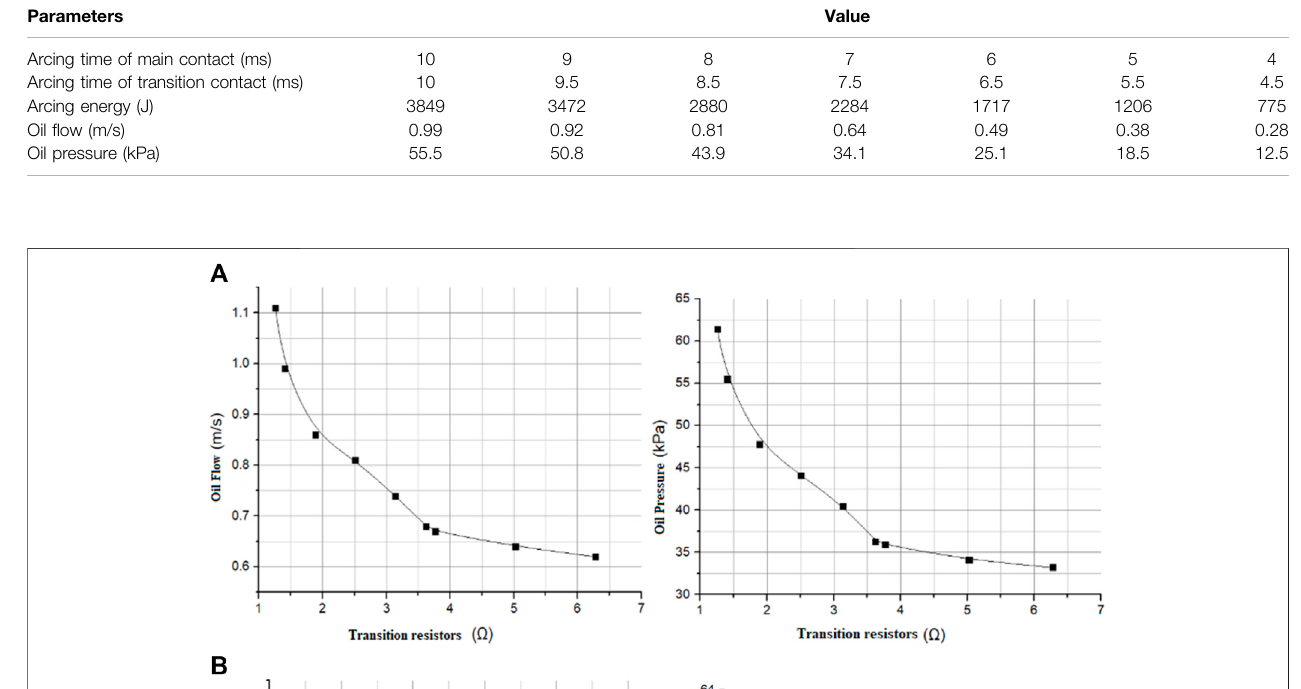
Frontiers in Energy Research |